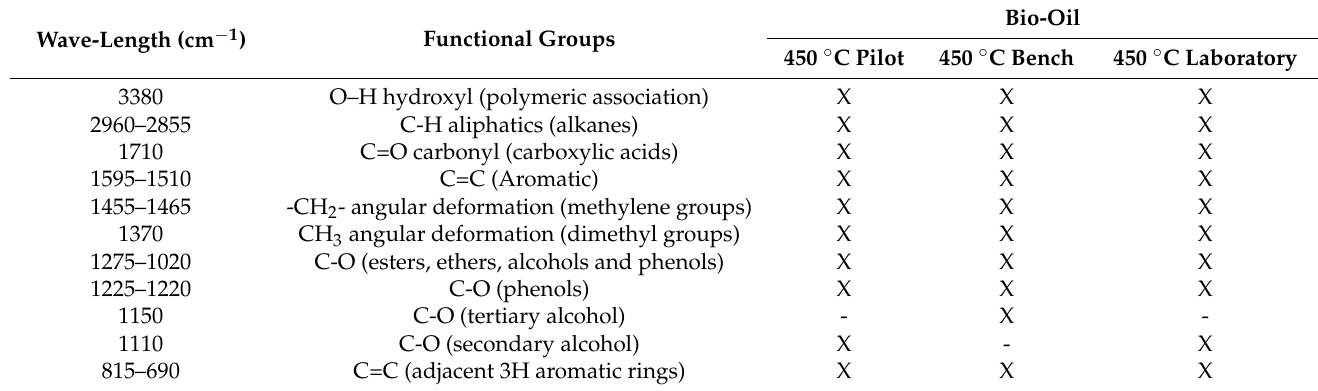
Table 7. Infrared bands identified in the bio-oils obtained by pyrolysis of Aça í seeds pyrolysis at 450 ◦ C and 1.0 atmosphere, in laboratory, bench, and pilot scales.